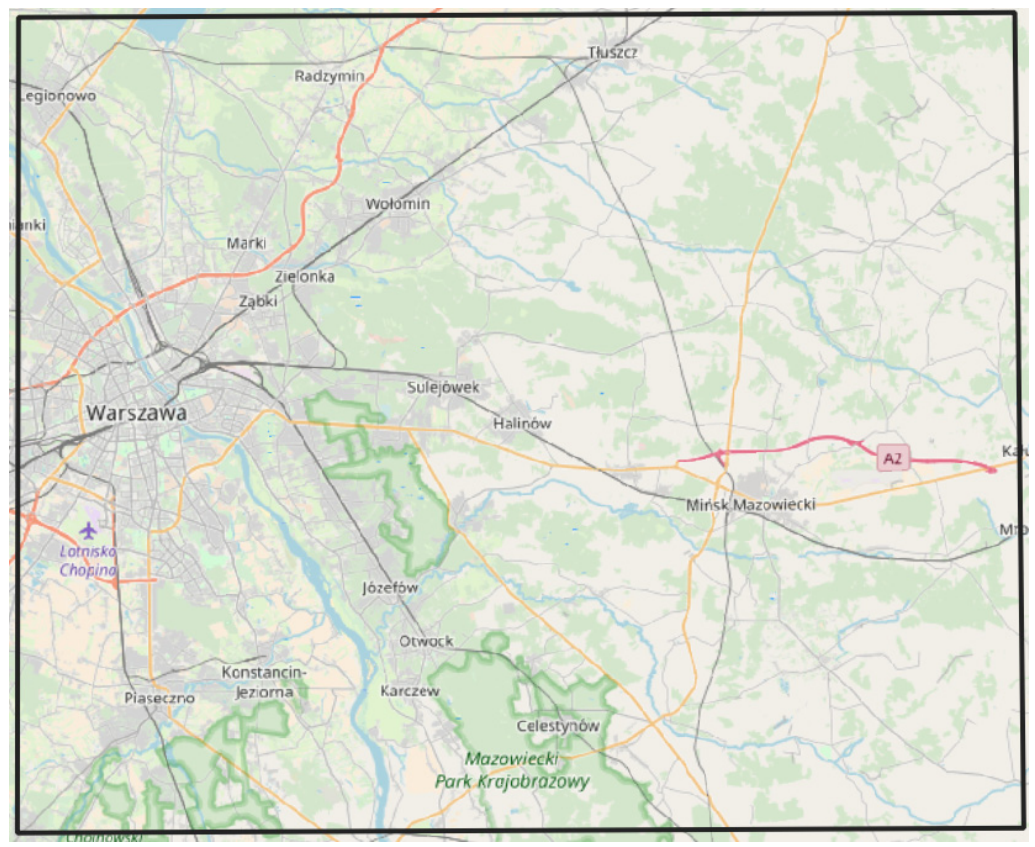
Figure 6. The area where the universality of solutions was tested, source: © OpenStreetMap contributors.